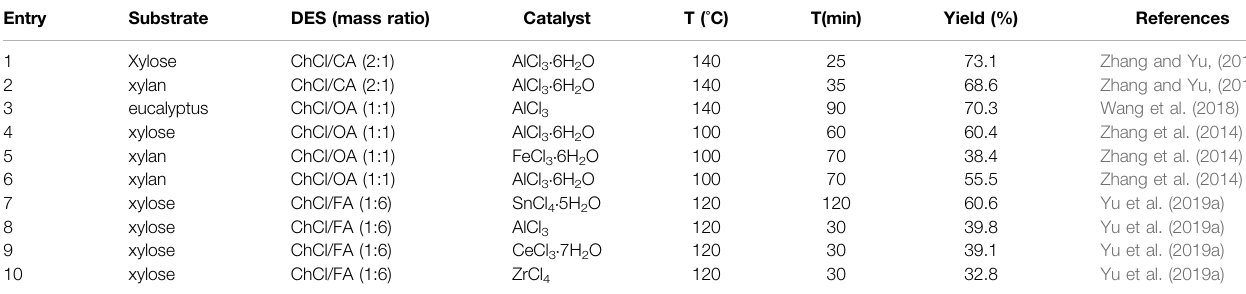
TABLE 4 | Adding metal chlorides in the DES system for furfural